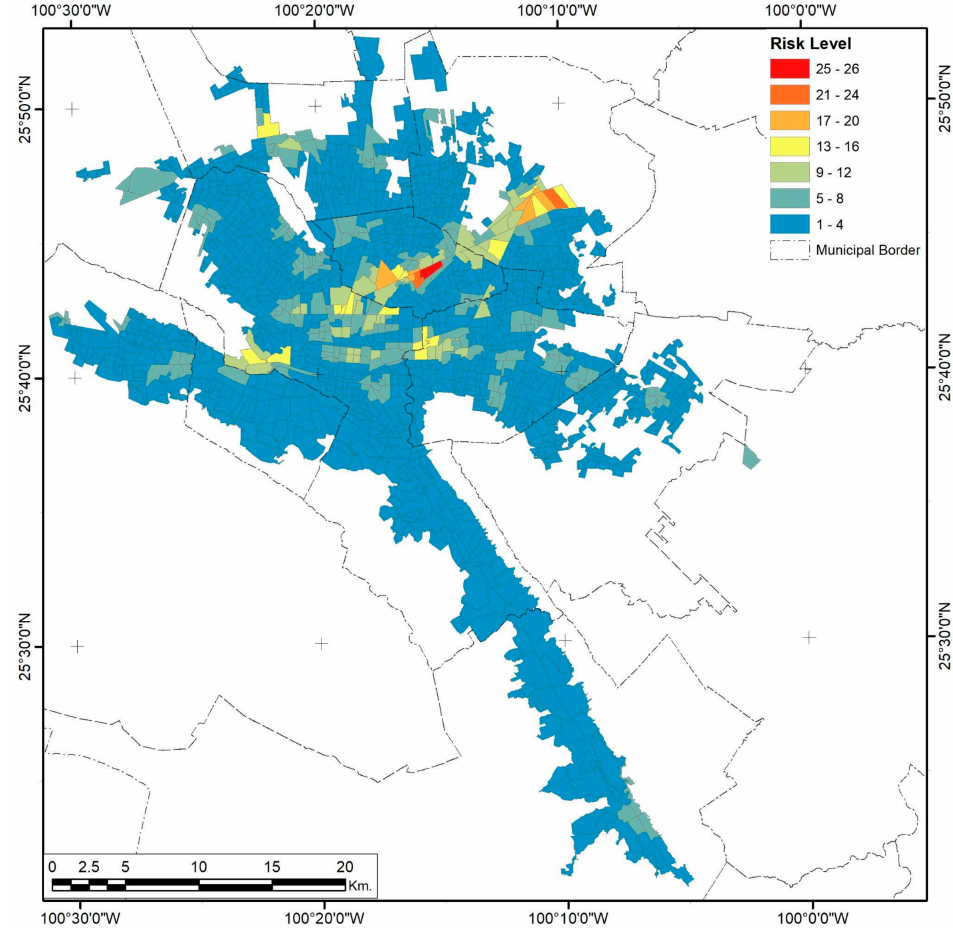
Figure 10. Monterrey City risk level by